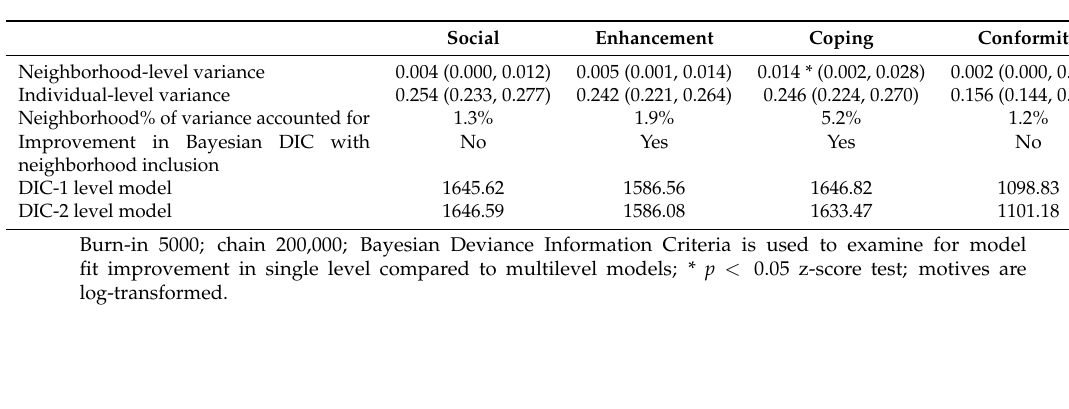
Table 2. Empty models of variation in drinking motives across neighborhoods (Intermediate Data Zones) (95% credible